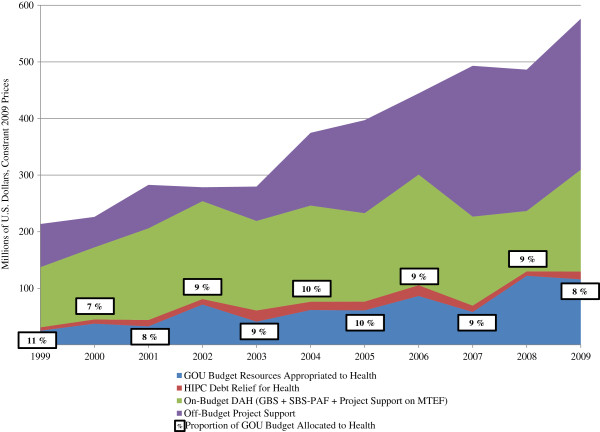
Trends in total health expenditures 1999–2009. Sources: MOH [28,39-43]; WHO [29]; MOFPED [30-38]; OECD/DAC [27]; Uganda Debt Network [44].